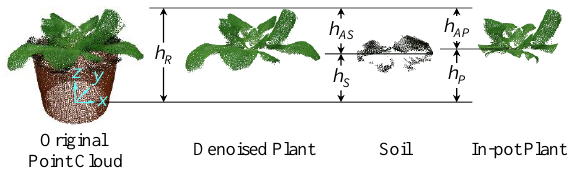
Figure 7. Definitions and principles of plant height measurement.